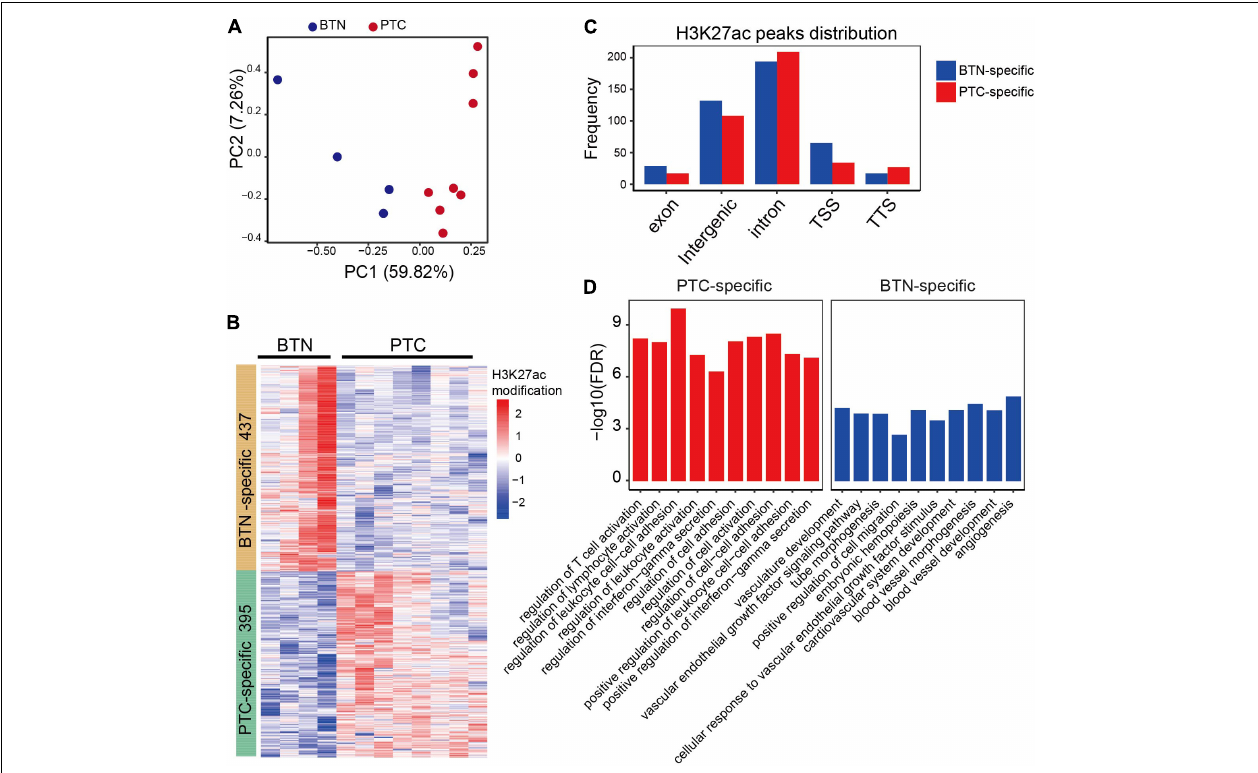
FIGURE 1 | Characterization of H3K27ac landscapes in PTC and BTN. (A) Principal component analysis of normalized PTC and BTN H3K27ac peaks. (B) Heatmap of differentiated H3K27ac-modified peaks between PTC and BTN. (C) Distribution of differentiated histone H3K27ac marks in genome. TSS, transcription start sites; TTS, transcription termination sites. (D) Bar plots showing top gene ontology (GO) terms of PTC and BTN-specific H3K27ac peaks. PTC, papillary thyroid carcinoma; BTN, benign thyroid